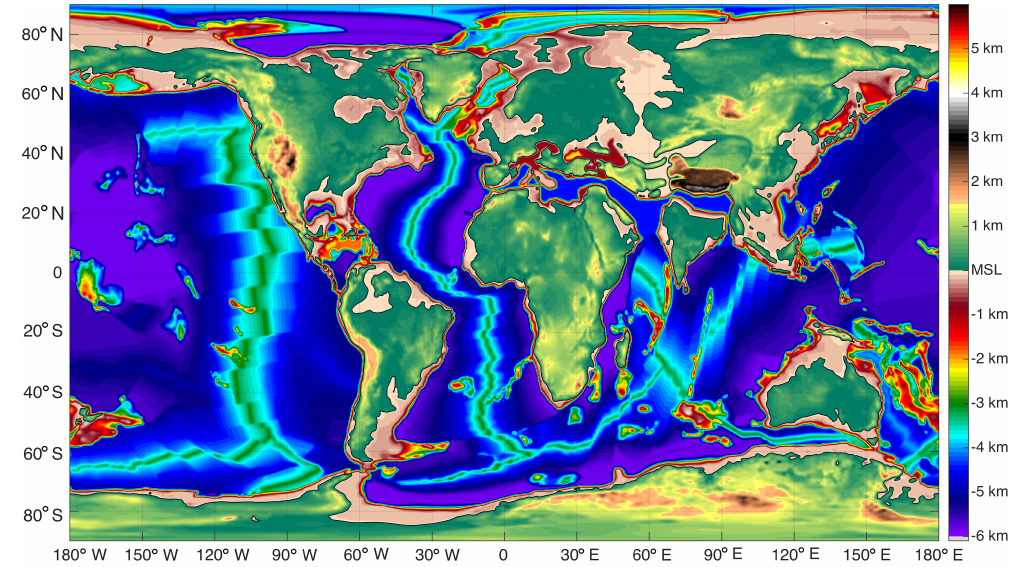
Figure 6. Final smoothed global topography and bathymetry reconstruction for the middle-late Eocene at